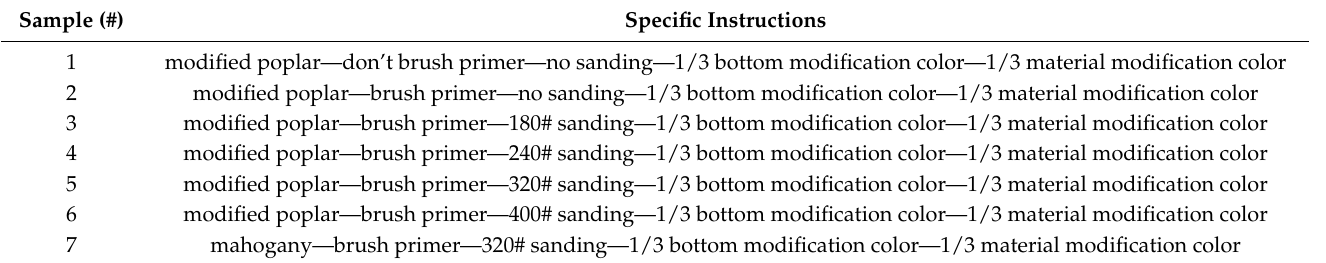
Table 2. Preparation of